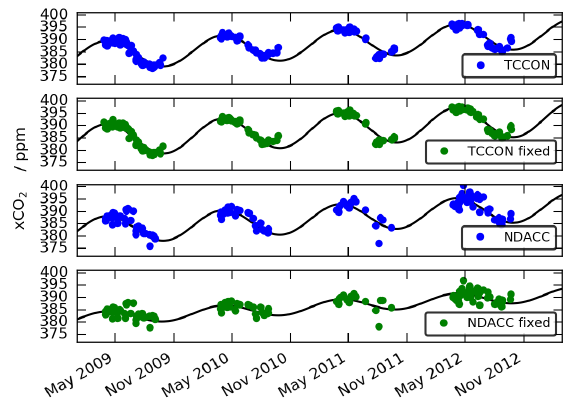
Figure 6. Fits to the different retrievals. Top two panels: standard TCCON retrieval and TCCON retrieval with fixed a priori. Bottom two panels: NDACC with TCCON and fixed a priori. The fit param- eters corresponding to Eq. (3) are presented in Table 3. For clarity, only a subset of the data from 2009 to 2013 is